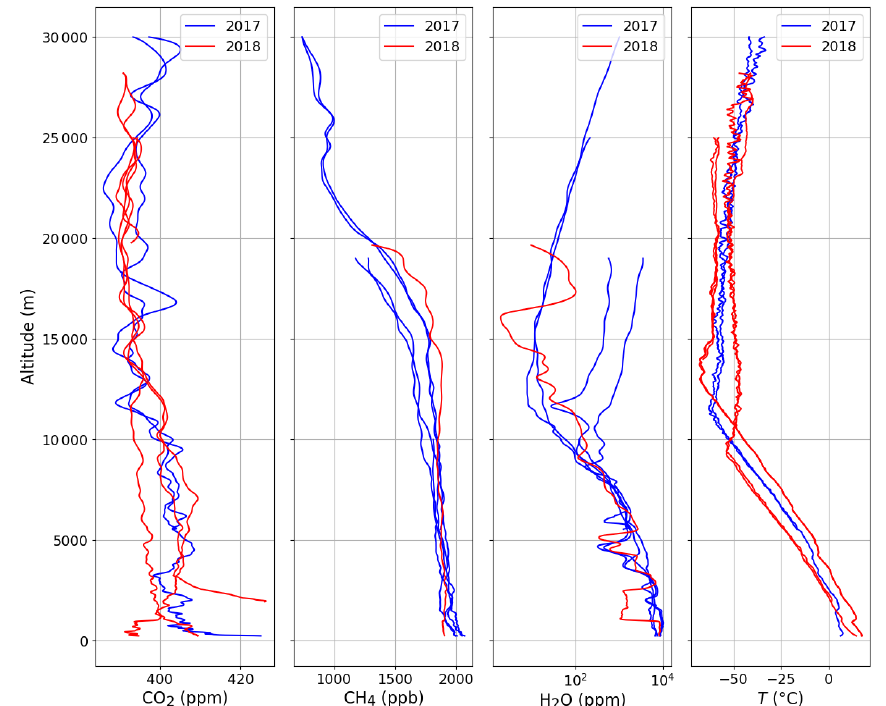
Figure 5. Balloon measurement: CO 2 , CH 4 , H 2 O and temperature vertical concentration profiles between November 2017 and April